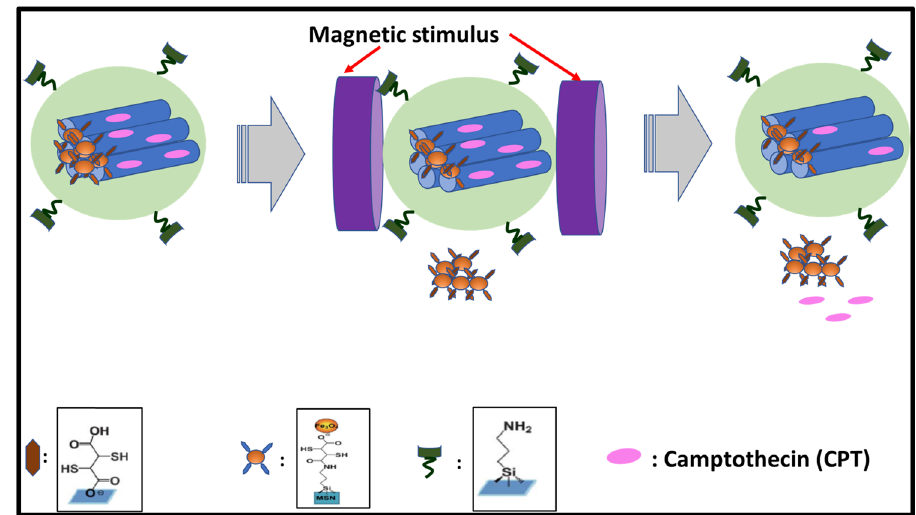
Figure 6: Schematic illustration of magnetic fi eld responsive